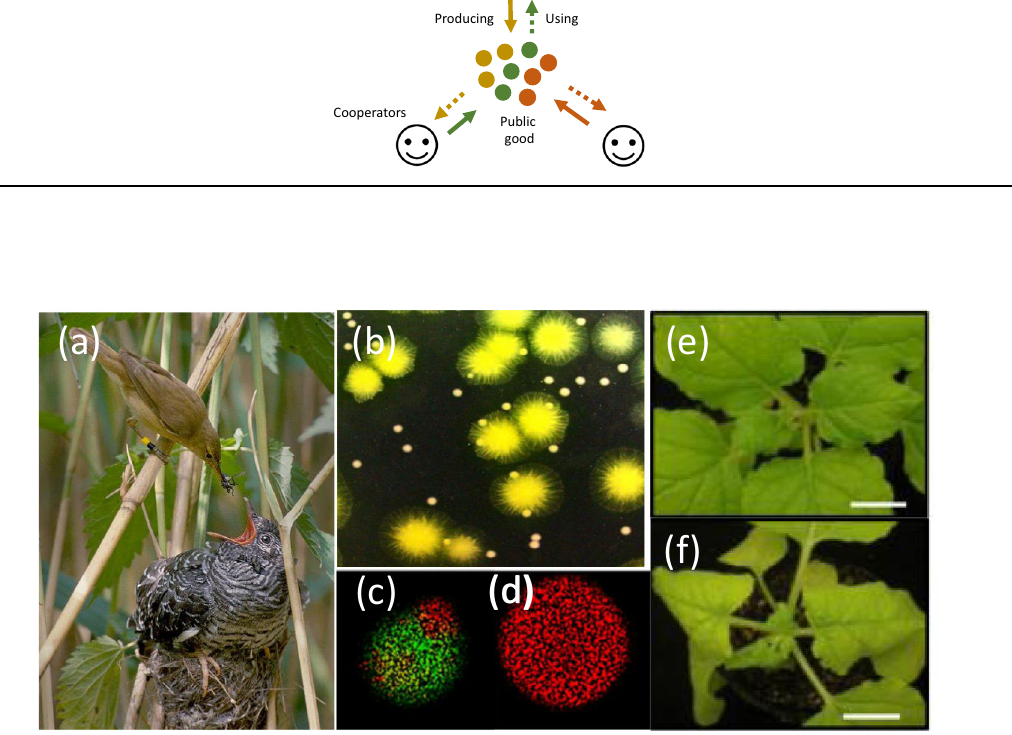
Fig. 1 Cheating occurs throughout the natural world, including in viruses. a The common cuckoo ( Cuculus canorus ) lays eggs in other birds ’ nests, here tricking a reed warbler ( Acrocephalus scirpaceus ) into taking care of a much larger cuckoo chick 21,143 . b Cells of the bacterial pathogen Pseudomonas aeruginosa which do not produce iron-scavenging molecules (labelled in green) are able to exploit those produced by others (labelled in white), and consequently grow much larger colonies 5 . c , d In Vesicular Stomatitis Virus (VSV), when a defective interfering genome (labelled in green) is grown in a mixed infection with wild-type VSV (labelled in red), the defective interfering genome exploits replicase proteins encoded by the wild-type cooperator, resulting in a colony ( c ) that is dominated by the defective interfering genome, and grows less effectively than a colony consisting just of the cooperative wild-type ( d ) 144 . e , f In cucumber mosaic virus (CMV) infections, a satellite (satCMV) exploits gene products encoded by the wild-type, substantially the wild type ( f ) 145 . Panel a from Per Harald Olsen (CC BY-SA 3.0), no changes made, reference 146 . Panel b from Melanie Ghoul, no changes